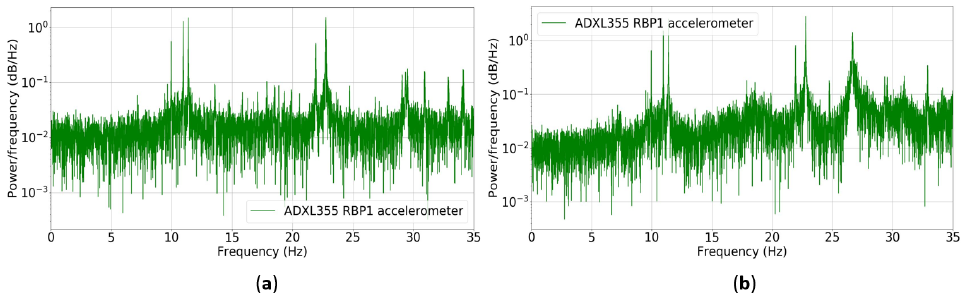
Figure 24. Dynamic response of the lightweight RC slab corresponding to the span 1–2: ( a ) Power spectral density of the ambient vibration. ( b ) Power spectral density of the forced vibration.